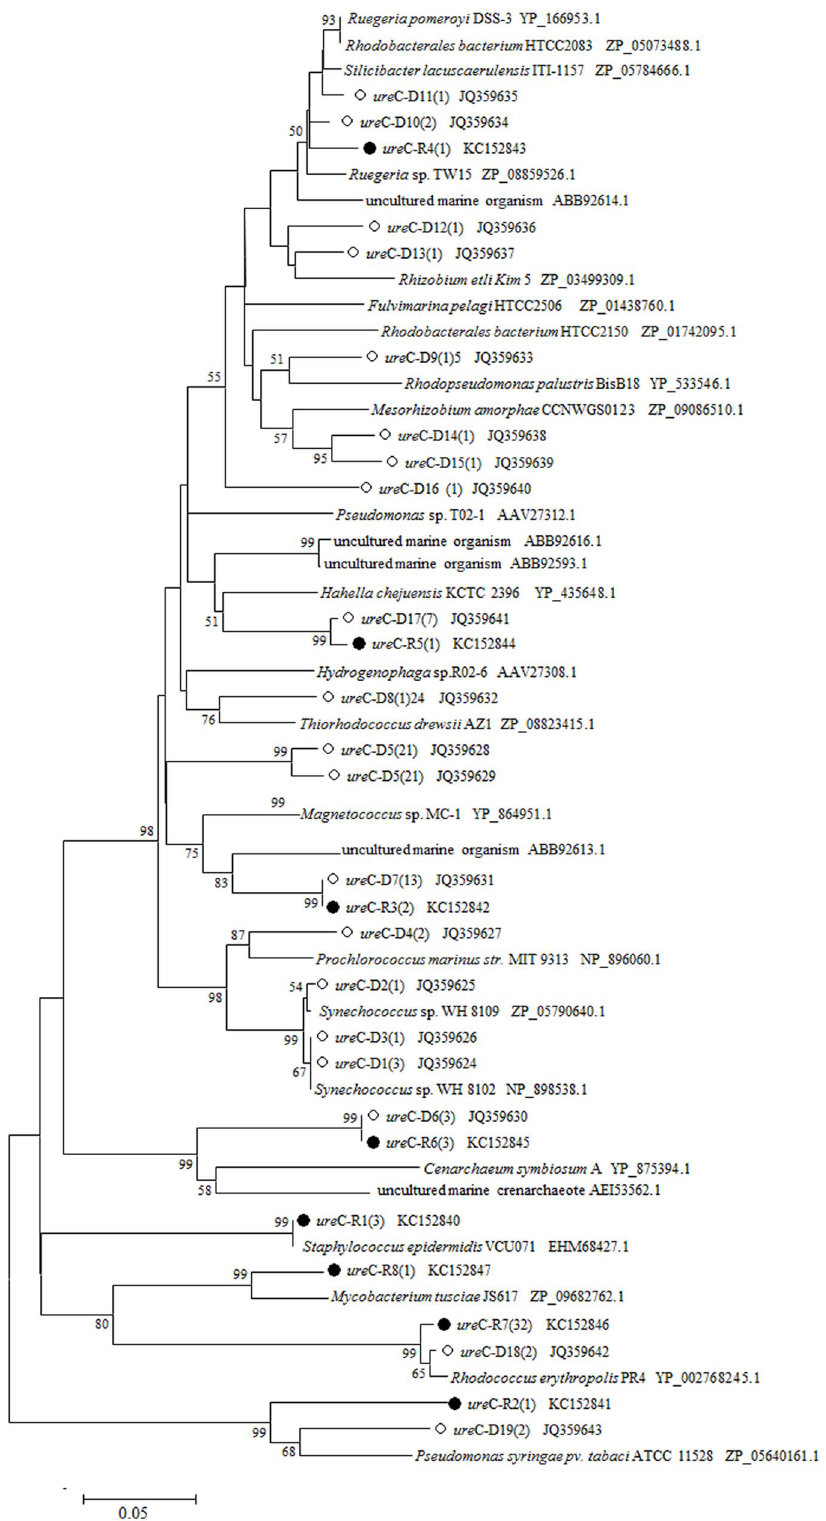
Figure 3. Unrooted phylogenetic tree based on urease alpha subunit (130aa) of sponge X.testudinaria using Neighbour-joining N method. The scale bar represents 0.05 substitutions per amino acids position. Bootstrap values (1,000 replicates) higher than 50% are shown. # mark mark and ure C-R mean the OTU in cDNA library. The number inside the parenthesis means and ure C-D mean the OTU in genomic DNA library, and the number of sequences within each OTU.